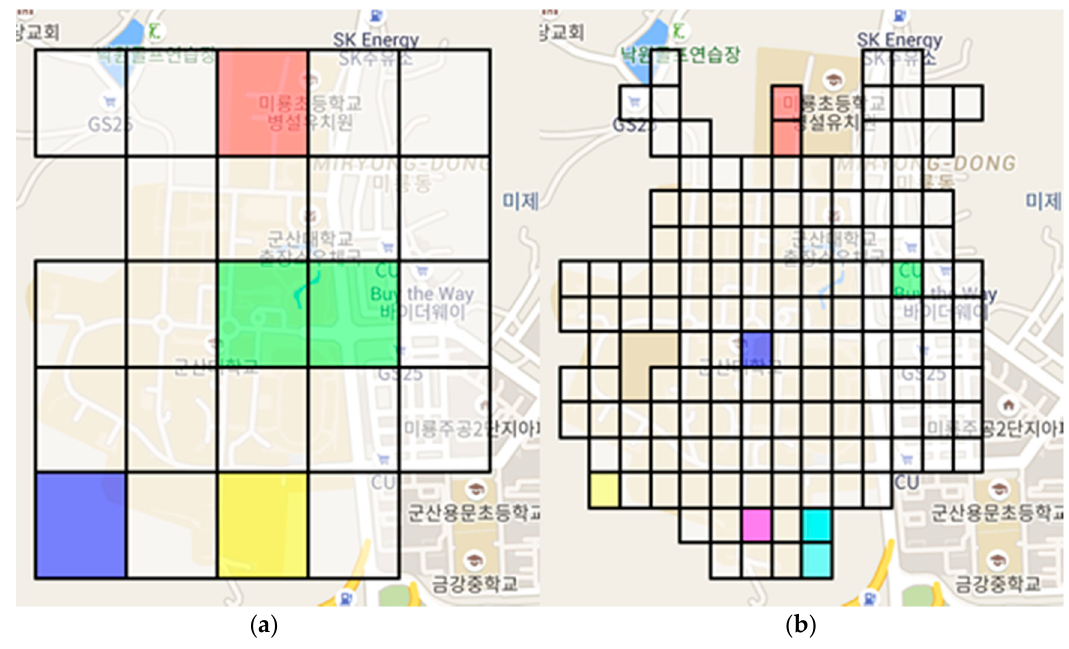
Figure 9. Teaming situation for KT: ( a ) 5 × 5 grids and ( b ) 15 × 15 grids.